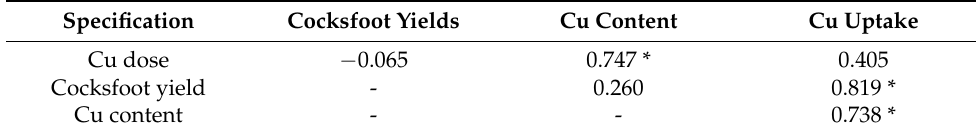
Table 8. Linear correlation coefficient between Cu doses, cocksfoot yield, Cu content, and Cu uptake by